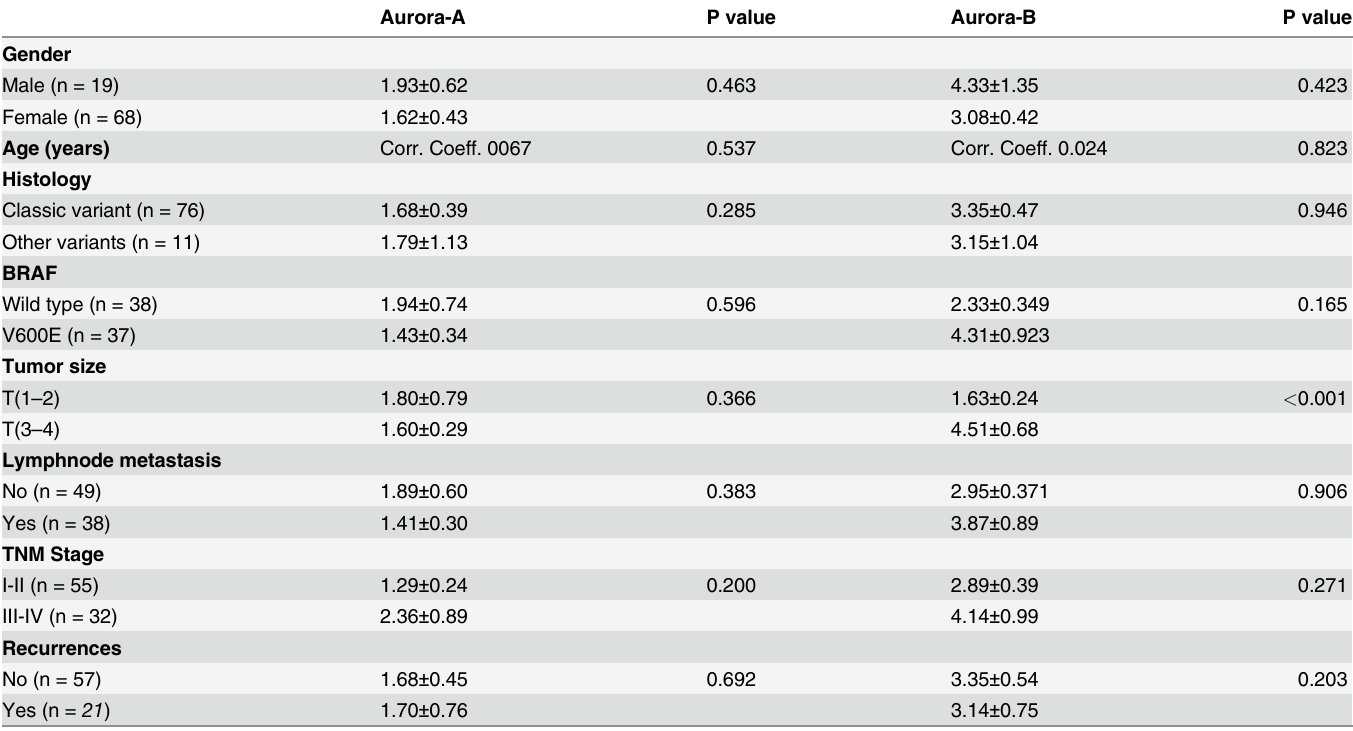
Table 2. Univariate statistical analysis of Aurora-A and Aurora-B expression and clinicopathological parameters in 87 PTC